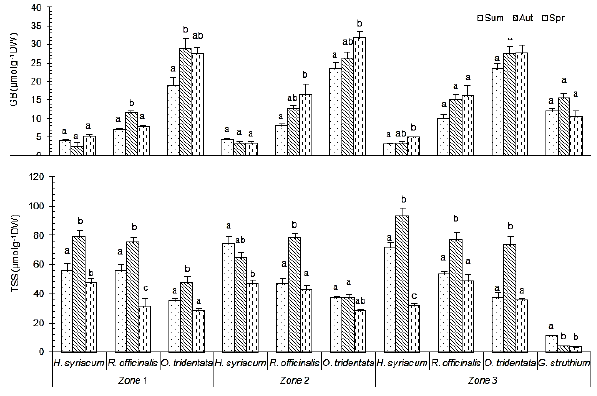
Fig. 6. Biplot from the principal component analysis (PCA) showing the relationships among proline (Pro), glycine betaine (GB), total soluble sugars (TSS), Na, K, Ca and Mg in plants, and environmental factors summarised as the ‘plot’ and ‘season’ variables. Gyspophily is a variable introduced to indicate whether the species are gyspophytes or